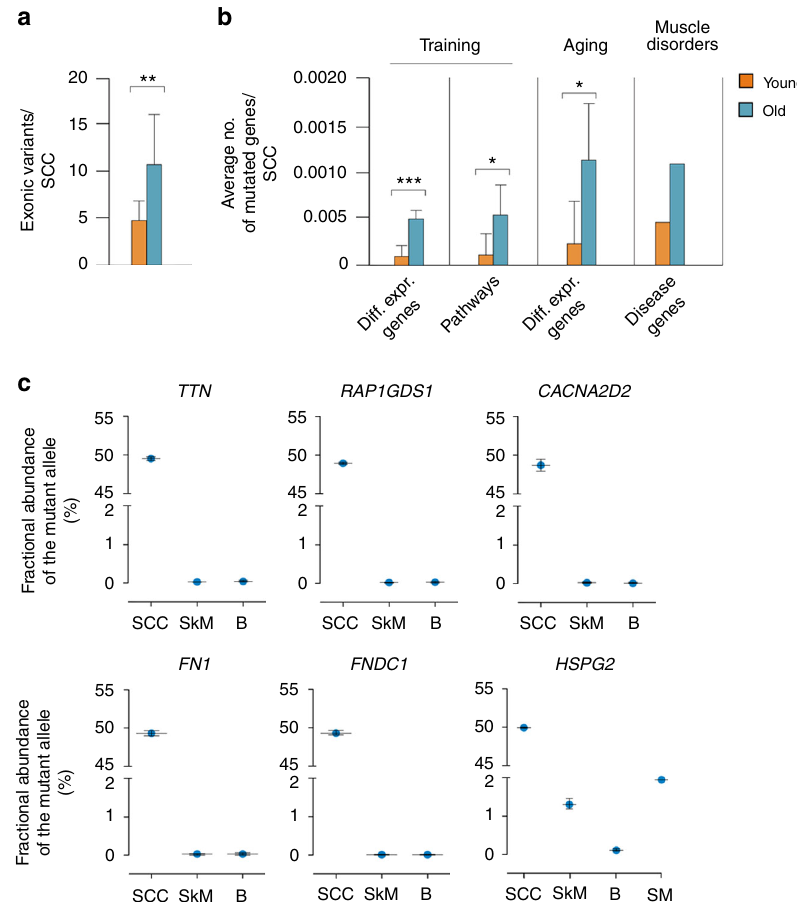
Fig. 4 Propagation of SC mutations to the SkM. a Average number of exonic variants (SNVs + indels) in young and old clones. ** P < 0.01 two-sided t -test. b Average number of genes harboring a mutation in young and old SCCs for different gene sets: differentially expressed after training ( fi rst); involved in pathways modulating the response to training 5 (second); differentially expressed with age (third); responsible for genetic muscular diseases (fourth graph). Gene lists were obtained from published data and public databases (see Supplementary Table 2). For muscle disease genes, see Supplementary Table 3. * P < 0.05, *** P < 0.001 two-sided t -test. c Abundance of mutated alleles of the indicated genes in the DNA of the clone from which the variant was originally discovered, the muscle, and the blood bulk of the related individual. The number of DNA molecules was detected by ddPCR and expressed as fractional abundance of all detected alleles (reference and mutant). For the HSPG2 mutation c.7825C>T, the fractional abundance was also measured in muscle cDNA to assess transcription of the mutant allele. SCC satellite cell clone, SkM skeletal muscle, B